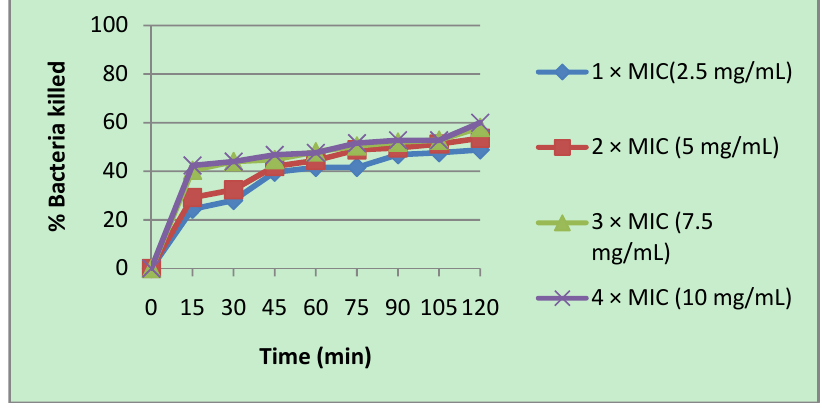
concentration, - denotes not determined. Figure 1. (a) Rate of kill of V. vulnificus (AL042) by crude methanol extract of Garcinia kola seeds. (b) Rate of kill of V. parahaemolyticus (AL049) by crude methanol extract of Garcinia kola seeds. (c) Rate of kill of V. fluvialis (AL040) by crude methanol extract of Garcinia kola